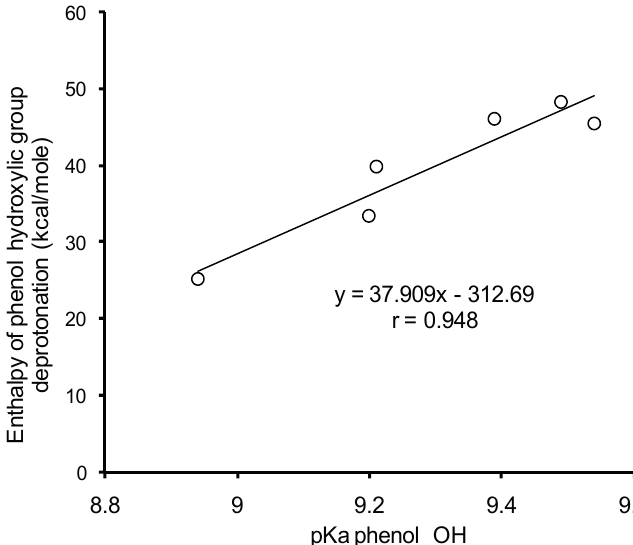
Figure 7. Correlation analysis of deprotonation enthalpy versus pKa values of phenyl hydroxyls of mono-HB and mono-HC acids.